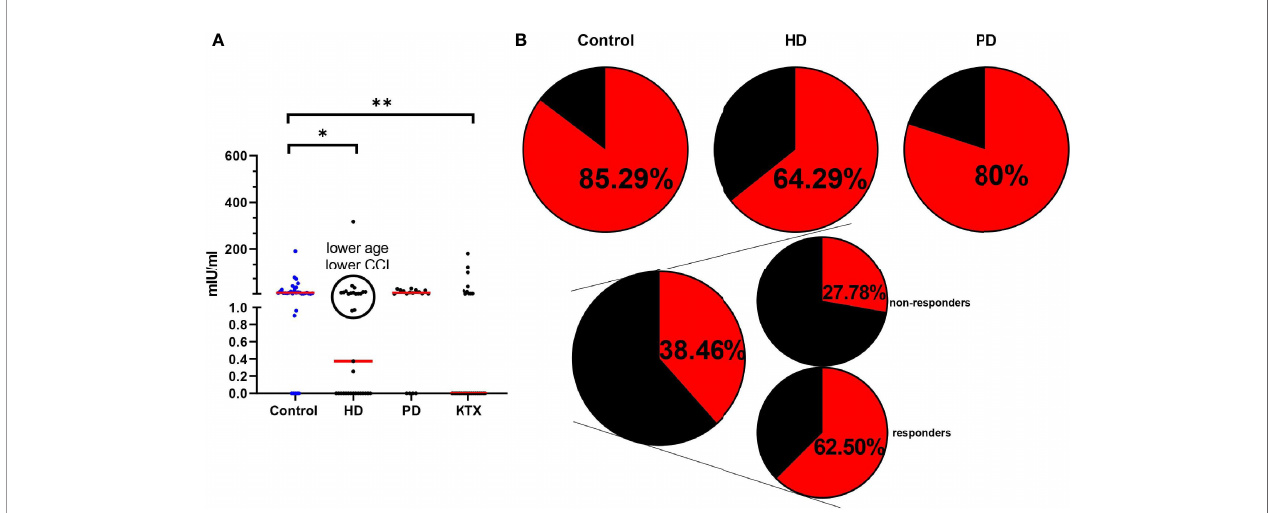
FIGURE 4 | Cellular immune response in analyzed groups measured with the use of IGRA test (A) The level (mIU/ml) of secreted INF- g after PBMC stimulation with SARS-CoV-2 S protein after the whole course of vaccination. The red line indicates the median. Statistical comparisons across groups were performed with the Kruskal – Wallis test. Dunn ’ s multiple comparison test with the reference to the control group (highlighted in blue) was used as a post-hoc test. Signi fi cant results are marked with * (p<0.05), ** (p<0.01), or *** (p<0.001). Similar to anti-S IgG data in the HD group, we observed two subpopulations. Namely, in the black circles, patients with positive IGRA are collected. The analysis has shown the lower age and CCI index in the group of HD patients with high INF- g secretion [age (p=0.3846) – median 60 (39 – 75) vs. 70 (22 – 94), CCI (p=0.3759) — median 4,5 (2 – 10) vs. 7 (1 – 11)]. (B) The percentage of positive IGRA patients. The circle divides patients into: IGRA positive (red) and IGRA negative (black). The detailed data (percentage) collects the number of patients with a positive IGRA test. The KTX group is additionally divided into: responders (anti-S IgG levels ≥ 39 BAU/ml) and non-responders (anti-S IgG levels <39 BAU/ml). HD, hemodialysis; PD, peritoneal dialysis; KTX, kidney transplant recipients.